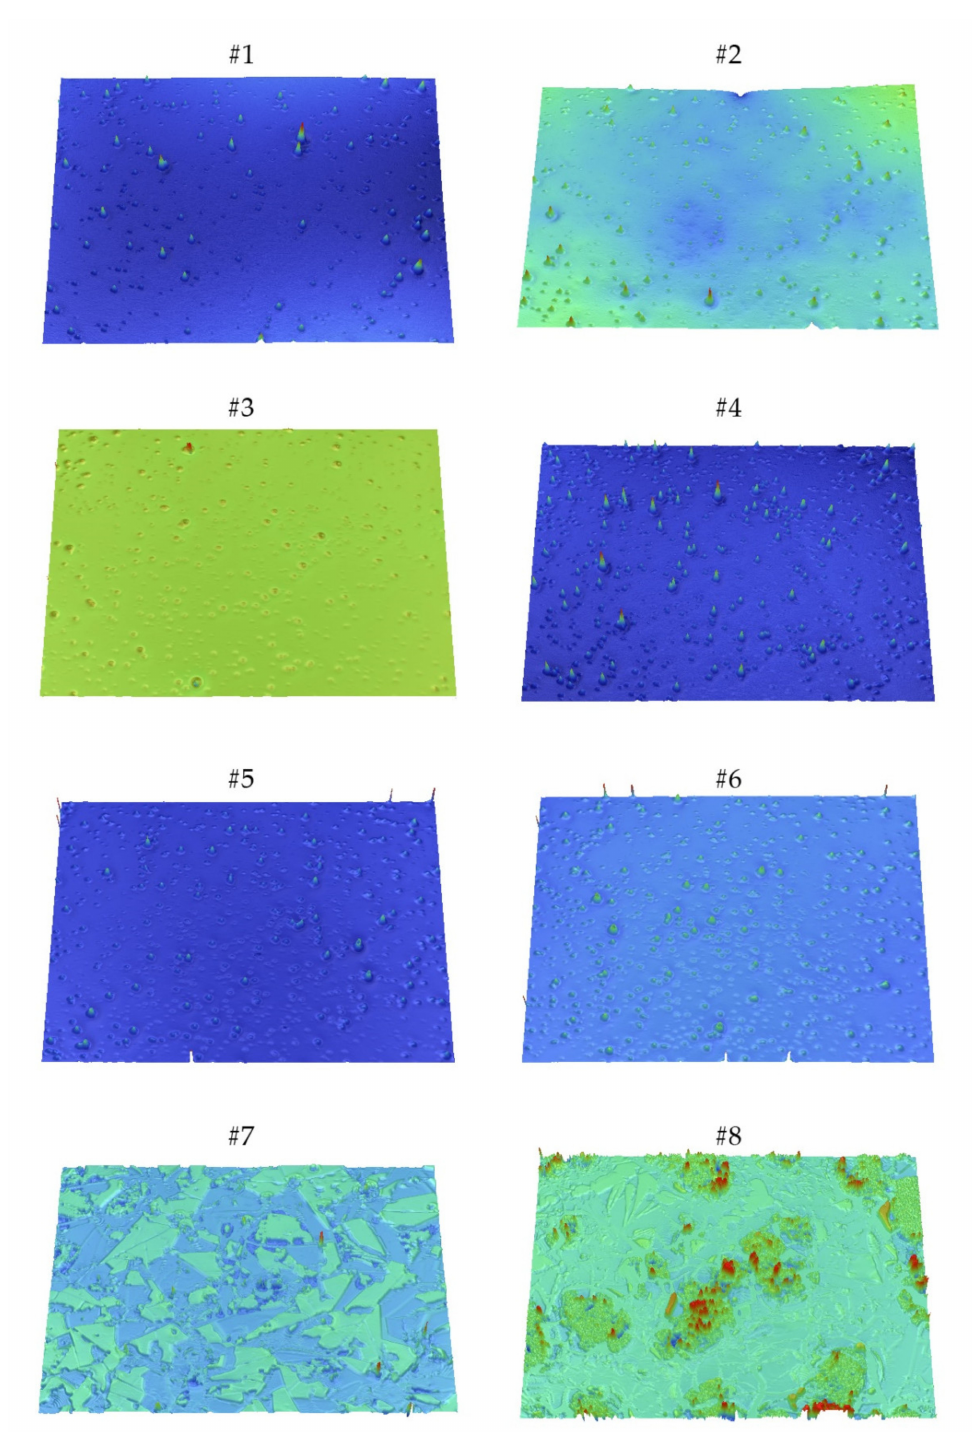
Figure 8. 3-D height maps of the obtained surfaces (sample number above the image). S dq can be also associated to the wetting degree of surface by various fluids. The developed interfacial area ratio (S dr ) describes in percentage the increasing surface area after applying coating compared to the flat surface of the support. It can be concluded that in the case of the samples produced by dip-coating, there are only microroughness due